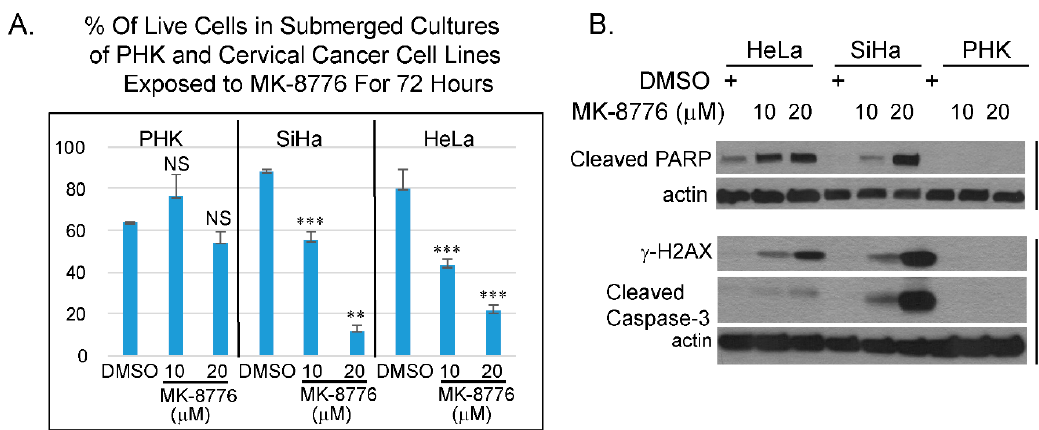
Figure 7. Cervical cancer cell lines are more sensitive to MK-8776 relative to uninfected PHK in submerged cultures. ( A ) A bar-graphs showing percentage of live cells of PHKs, cervical cancer cell lines, SiHa or HeLa, as determined by trypan blue assay. Data were averages from triplicate. *** indicates statistically significant difference ( p < 0.005) of living cells in treated cultures relative to DMSO treated controls. ( B ) Immunoblot analyses of lysates from submerged cultures of HeLa, SiHa and PHK revealed that MK-8776 induced cleaved PARP, γ -H2AX, and cleaved caspase 3 in concentration dependent manner in HeLa and SiHa, but not in PHKs. Actin served as loading control.